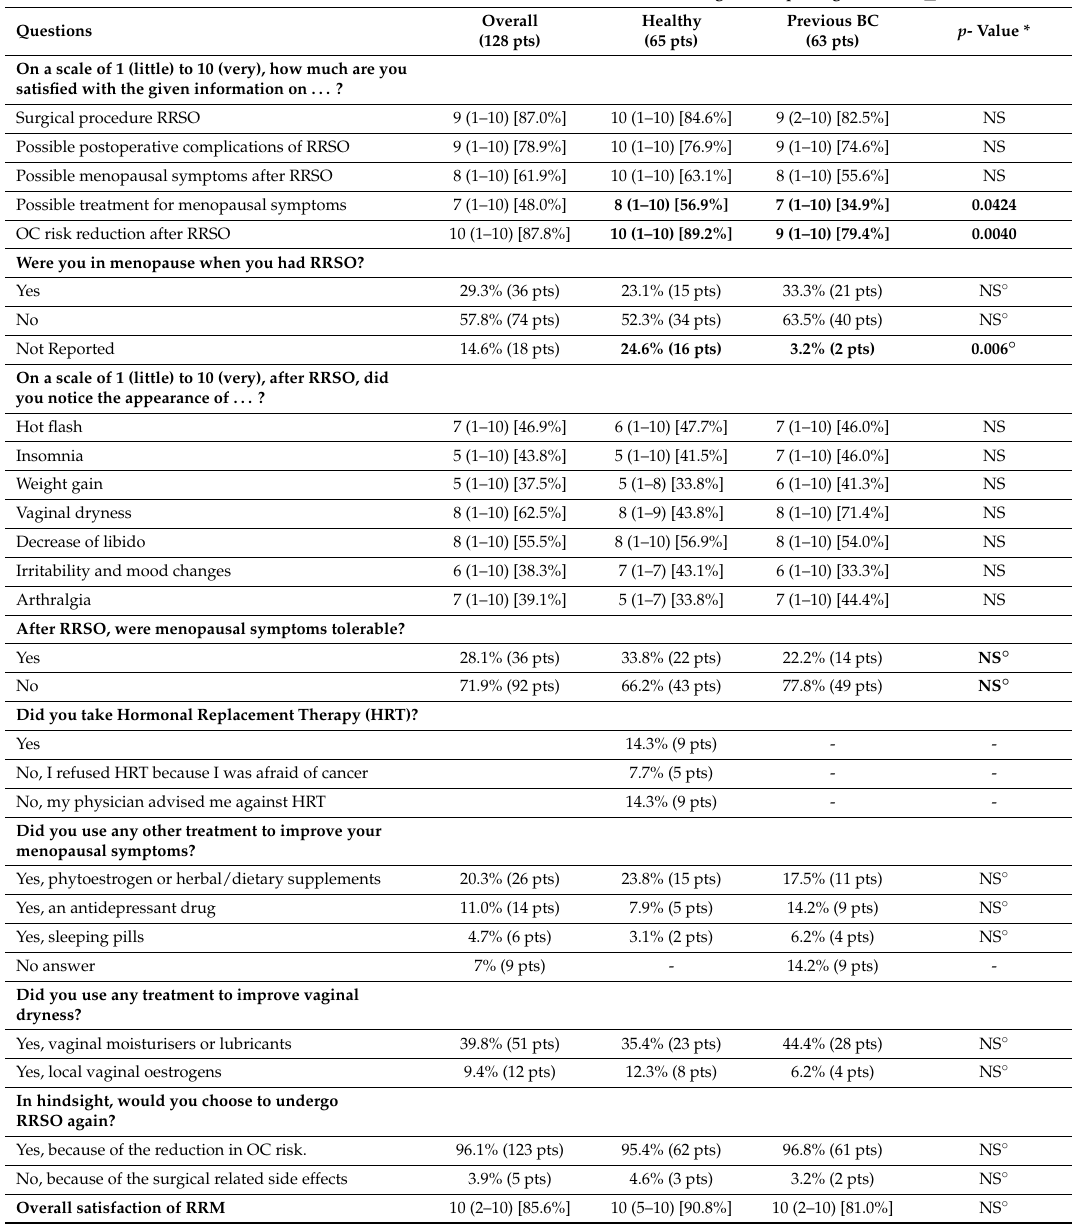
Table 4. Satisfaction, concerns, menopausal symptoms and related treatment among carriers who underwent Risk-Reducing Salpingo-Oophorectomy (RRSO) considering their medical history (healthy carriers and carriers with a previous